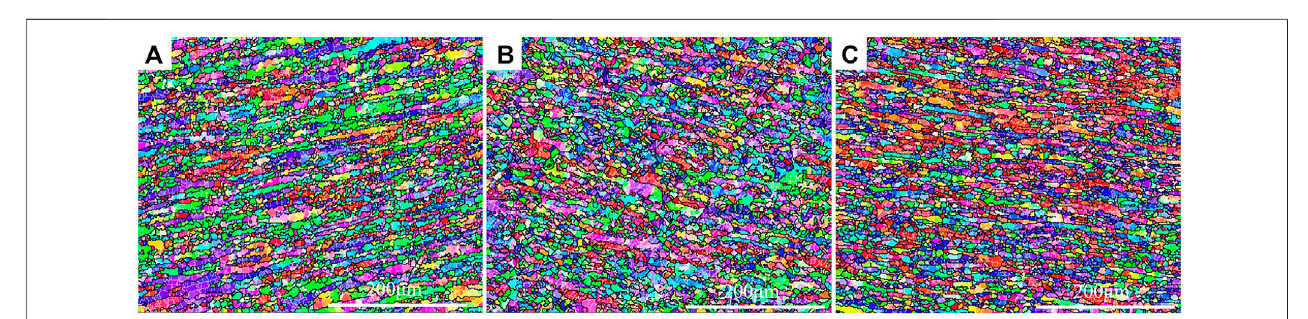
FIGURE 4 | EBSD diagram of sample after CSE forming. (A) 1#, (B) 2#, (C) 3#.